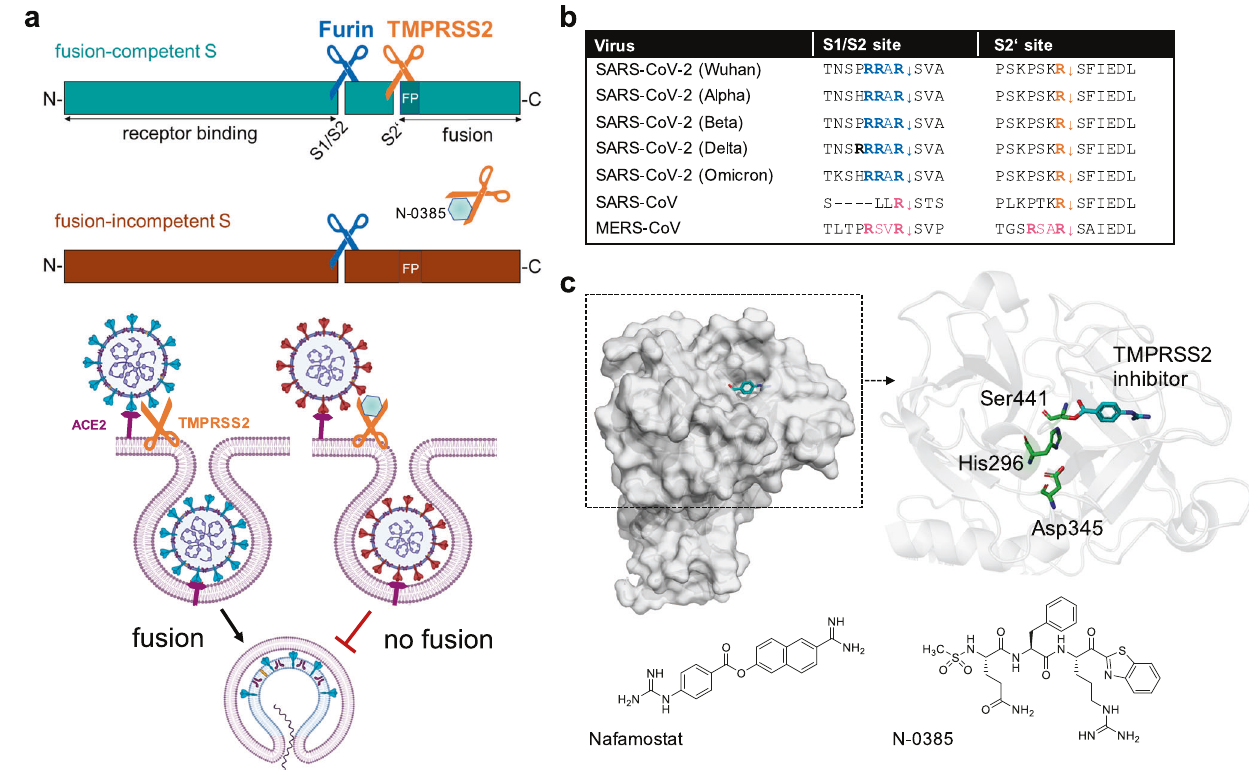
Fig. 1 Inhibition of SARS-CoV-2 spike cleavage by TMPRSS2 inhibits virus entry. a Upper panel: Schematic representation of SARS-CoV-2 S cleavage by furin at the S1/S2 site and subsequent cleavage at the S2 ’ site by TMPRSS2. Cleavage at the S2 ’ site exposes the fusion peptide (FP), priming S for membrane fusion (cyan-colored S). Inhibition of TMPRSS2 by N-0385 (blue hexagon) causes incomplete cleavage of S (red- colored S). Lower panel: Complete cleavage of S supports membrane fusion and the release of the viral genome into the target cell. TMPRSS2 inhibition results in incomplete S cleavage and thus prevents fusion and virus entry. b Alignment of the amino acid sequences at the S1/S2 and S2 ‘ sites of different SARS-CoV-2 variants of concern, zoonotic SARS-CoV and MERS-CoV. Amino acid motifs highlighted in blue and orange are cleaved by furin and TMPRSS2, respectively. Motifs highlighted in pink are most likely cleaved by TMPRSS2. c Crystal structure of human TMPRSS2 (SRCR and serine protease domain) in complex with nafamostat (cyan, PDB: 7MEQ; upper left panel). Catalytic